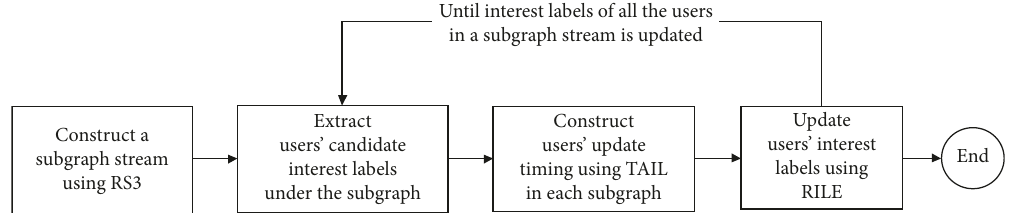
Figure 1: An illustration diagram showing links between RS_UNITE_SS and the proposed algorithm.